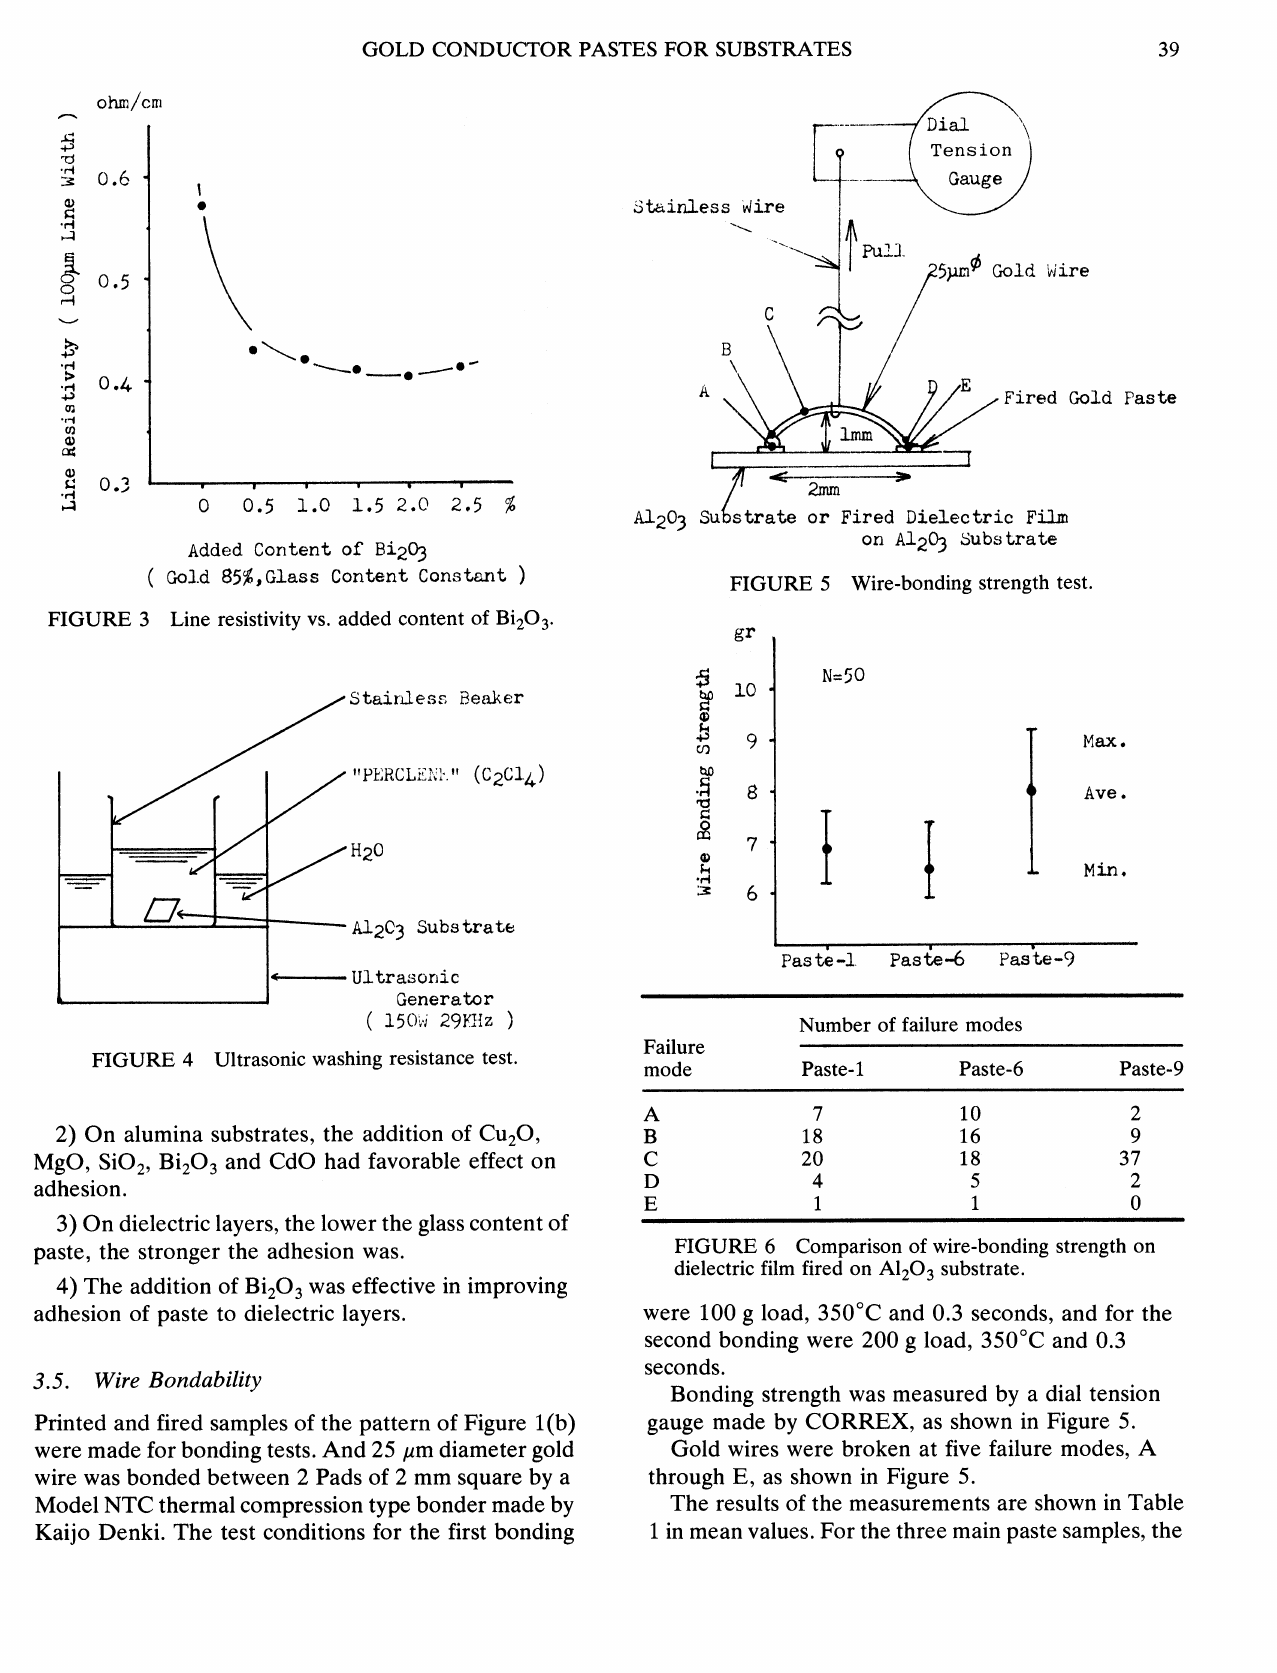
FIGURE 5 Wire-bonding strength test.